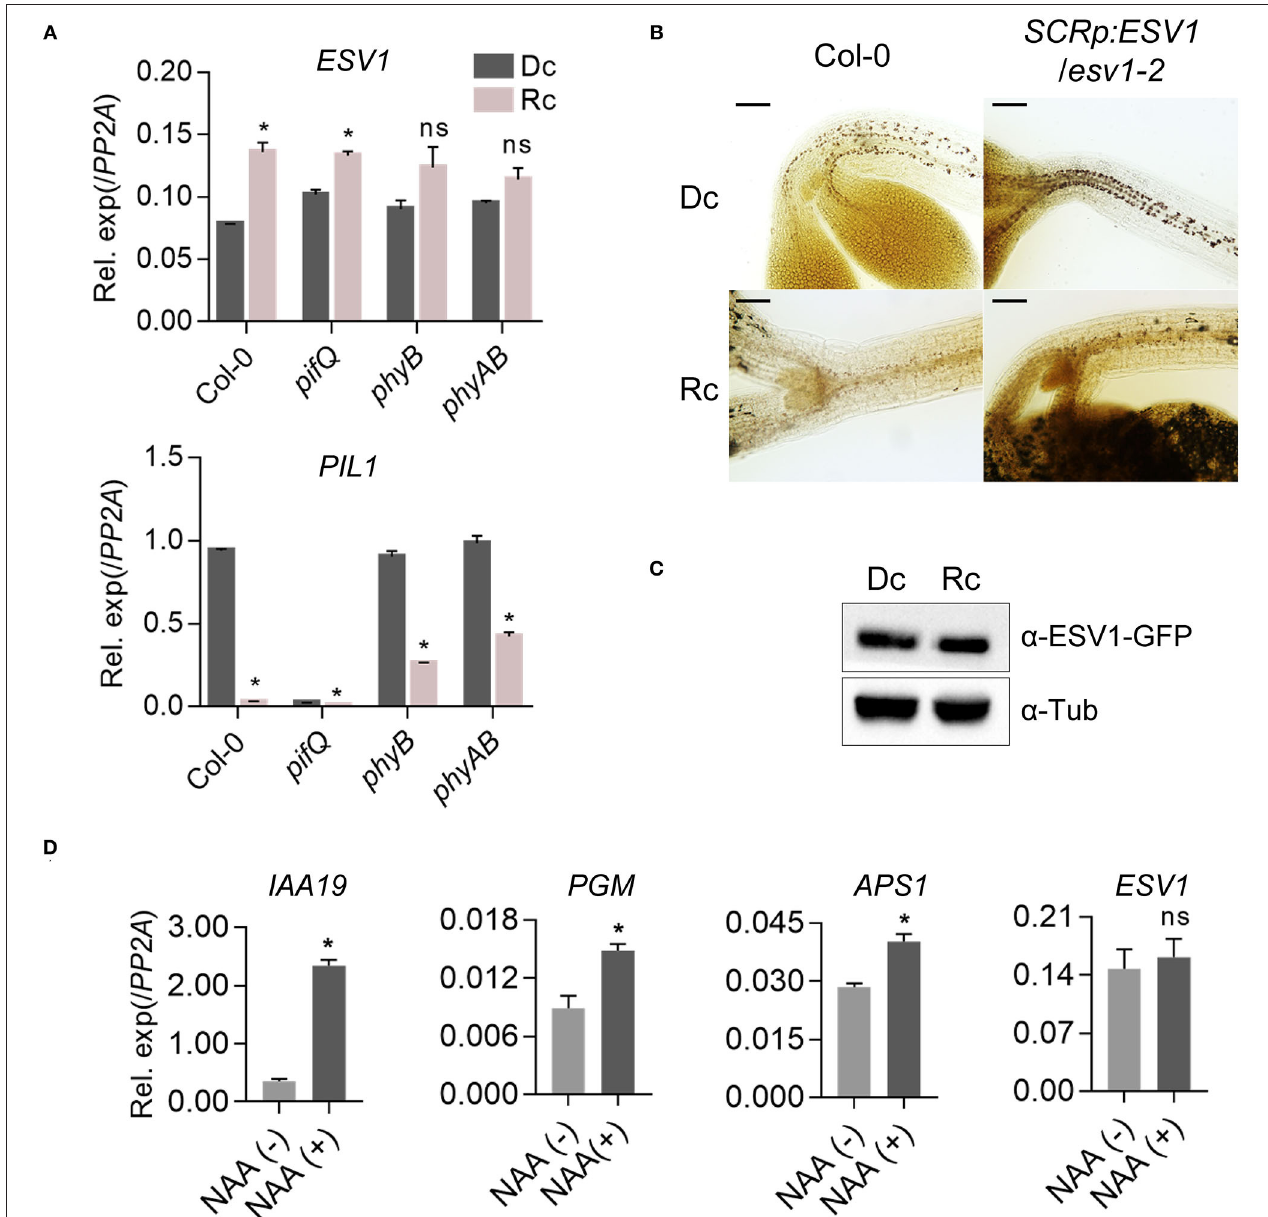
FIGURE 4 | PhyB does not repress ESV1 to degrade endodermal starch granules. (A) No repression of ESV1 mRNA expression by red light. Three-day-old seedlings grown either in the dark (Dc) or red light (Rc) were used for mRNA expression analysis. Col-0: wild type, pifQ : pif1 pif3 pif4 pif5 mutant. phyB : phyB-9 mutant. phyAB : phyA-211 phyB-9 double mutant. Relative mRNA expression was normalized by PP2A . Asterisks indicate significant differences from dark condition (* p < 0.05; Student’s t -test). n.s indicates no significant difference. Error bars = SEM ( n = 3 biological replicates). (B) Degradation of starch granules by red light even in transgenic seedlings expressing ESV1 under the SCR promoter. Endodermal starch granules were visualized by staining 3-day-old seedlings grown in dark (Dc) or red light (Rc) with Lugol’s iodine. Col-0: wild type, SCRp:ESV1 / ESV1-2 : transgenic plants expressing ESV1 by endodermis-specific SCR promoter in the ESV1-2 mutant background. Scale bar = 100 µ m. (C) No destabilization of ESV1 protein by red light. Transgenic seedlings expressing ESV1-GFP under the 35S promoter in the wild type background ( 35Sp:ESV1-GFP ) were grown for 4 days either in the dark (Dc) or under red light (Rc) and ESV1 -GFP protein levels were detected by Western blot using a GFP-specific antibody ( α -GFP). α -tubulin was detected using an α -tubulin-specific antibody ( α -Tub). The intensity of ESV1 -GFP was normalized by α -tublin ( n = 3, biological replicates). (D) No activation of ESV1 mRNA expression by auxin. Seven-day-old seedlings grown in the light on a nylon mesh were transferred to media with [NAA( + )] or without [NAA(-)] auxin. At 48h after the incubation, the root tips were removed with a blade and collected for RNA purification. Relative mRNA expression was normalized to PP2A . Asterisks indicate significant differences from NAA(-) condition (* p < 0.05; Student’s t -test). ns indicates no significant difference. Error bars = SEM ( n = 3 biological